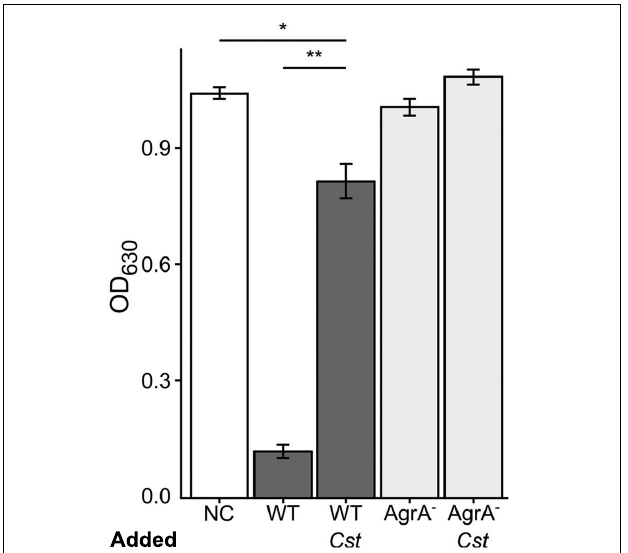
FIGURE 4 | Staphylococcus aureus exhibits decreased hemolytic activity when grown with C. striatum CFCM. Hemolysis of rabbit erythrocytes was quantified 30 m after exposure to BHI, as the negative control (NC), or CFCM from S. aureus strains grown in the presence of AIP-1 alone or plus the addition of C. striatum CFCM ( Cst ) for the wild-type (WT) and agrA::Tn mutant (AgrA − ), n = 3 each. Decreased OD 630 is indicative of S. aureus hemolytic activity. Growing S. aureus in the presence of C. striatum CFCM significantly diminished the hemolytic activity produced by the WT. In contrast, the agrA::Tn mutant (AgrA − ) was incapable of significant hemolysis in either condition. Data were analyzed by two-tailed Student’s t -test with Bonferroni correction for multiple testing ( ∗ p < 0.005, ∗∗ p < 0.00005). Error bars represent SEM.